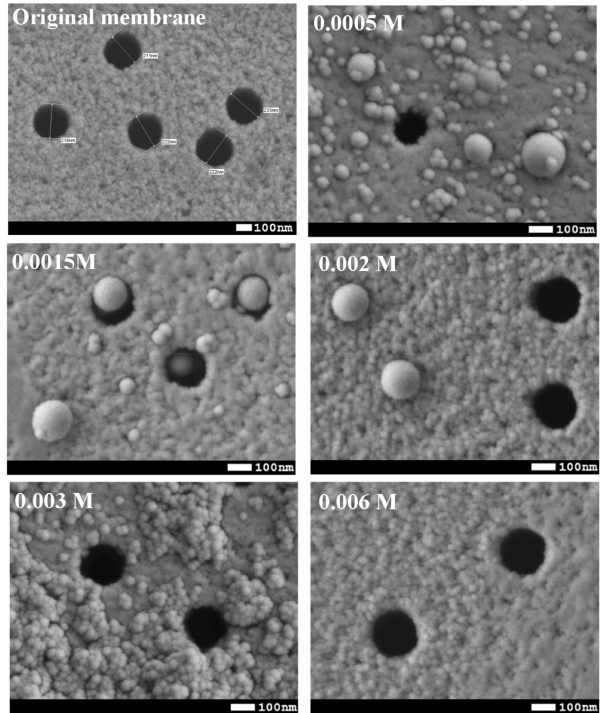
Figure 3. SEM images of original PET membrane and PET-Si NPs membranes at di ff erent concentration of